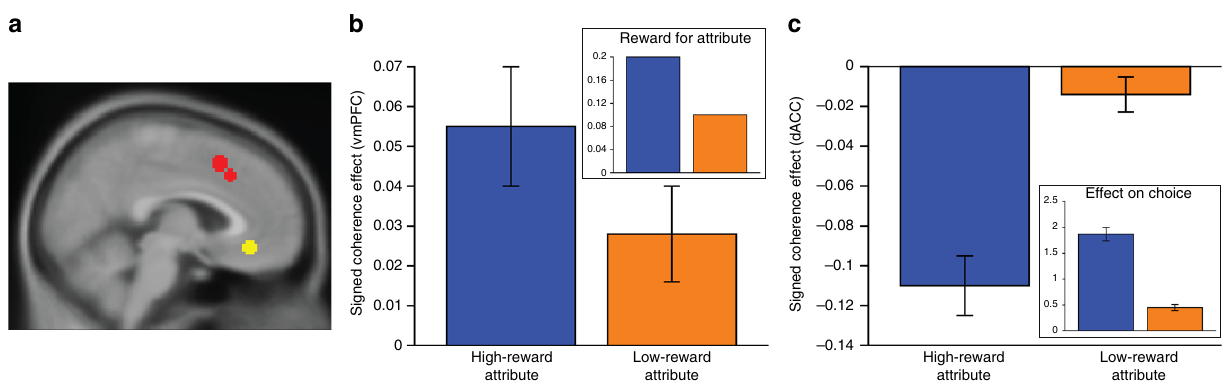
Fig. 3 vmPFC and dACC differentially encode the relative evidence for the high- and low-reward attributes. a vmPFC (yellow) and dACC (red) ROIs were de fi ned a priori based on the relevant fi ndings from research on integration of information from multi-attribute stimuli displayed on a normalized Montreal Neurological Institute (MNI) template 3,11 . b vmPFC positively tracked the evidence each attribute provided for the chosen response (signed coherence), but it did not weigh the evidence for both attributes equally. Rather, responses to the two attributes were weighed in proportion to the reward expected for responding correctly to that attribute. For reference, the inset shows the reward amounts (in dollars) expected for each attribute. c dACC tracked how little evidence was available for these two attributes, weighing the evidence for the two attributes in proportion to the in fl uence that attribute will have on the ultimate choice (inset from Fig. 2b), potentially re fl ecting the amount of attention placed on that attribute while forming a decision. Regression coef fi cients are plotted with their corresponding